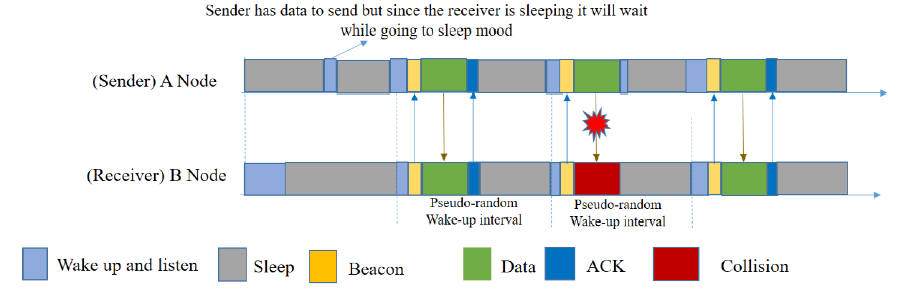
Figure 11. Packet transmission in PW-MAC [34].